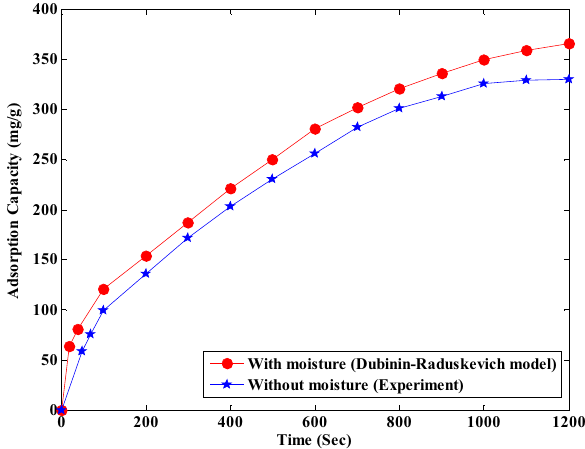
With moisture (Dubinin-Raduskevich model) Without moisture (Experiment)